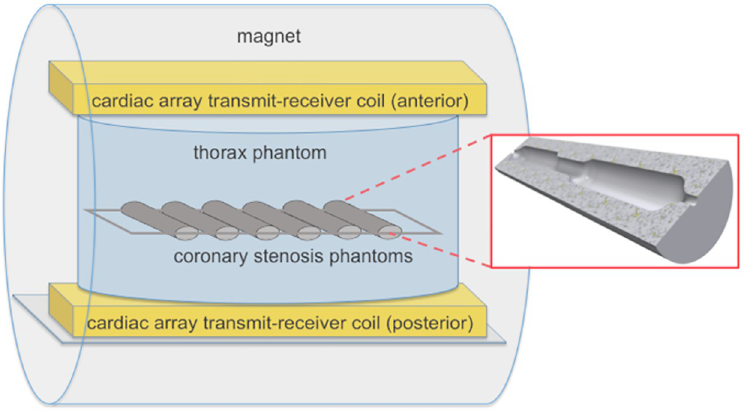
Fig 1. Side view of the MRI scanner showing the position of the stenosis phantoms in the thorax phantom and the cardiac array transmit-receive coil. Magnified out in the red box is the cross-section of a stenosis phantom (computer-aided design (CAD)-Model for 3D-printing) with a stenosis of 40% in the center of the vessel phantom.